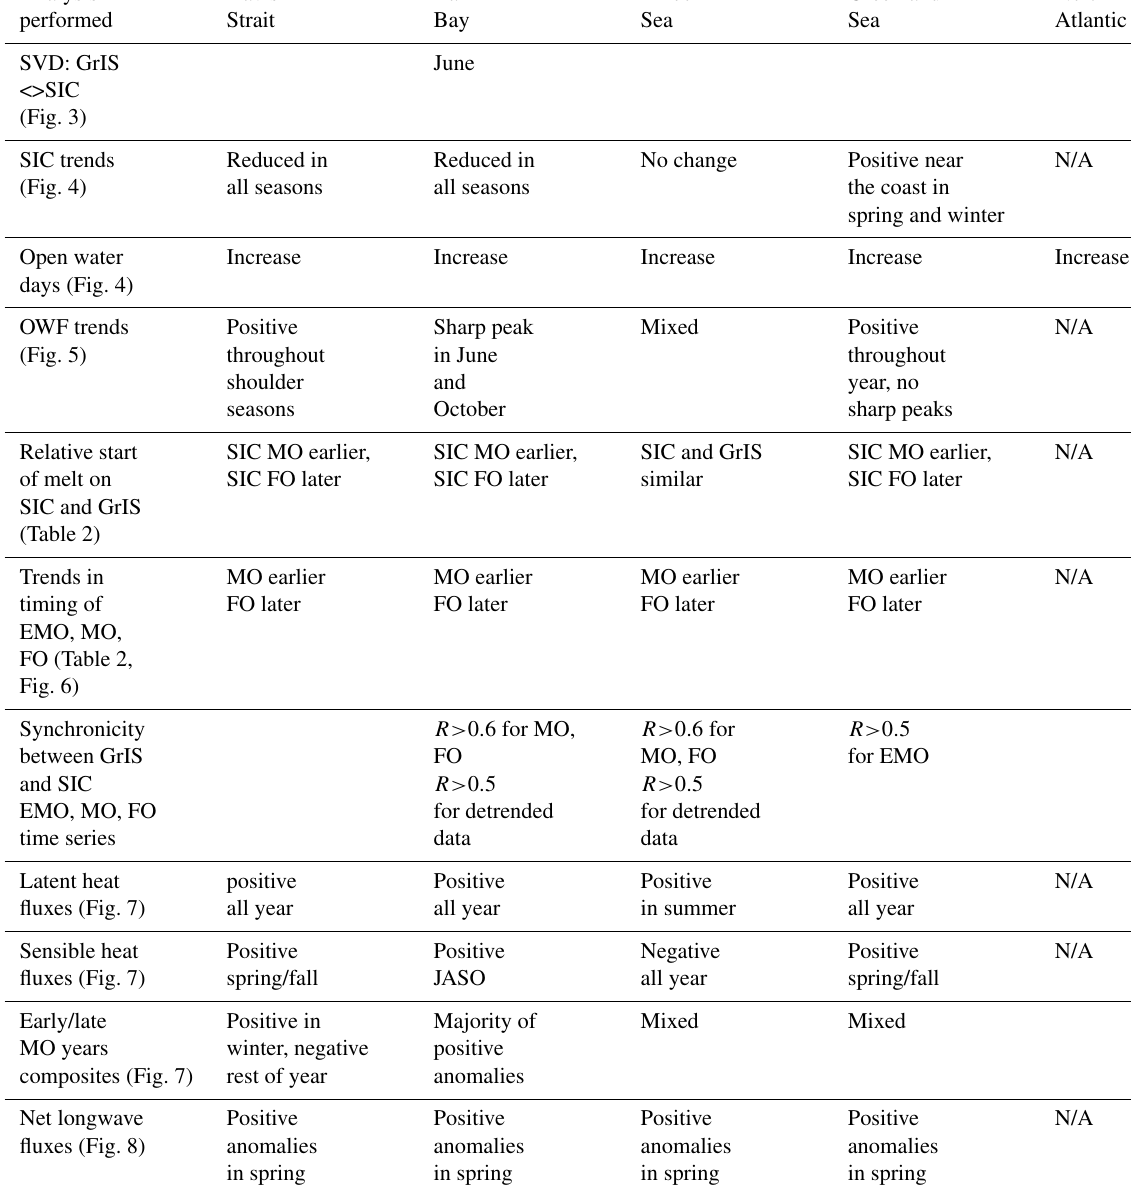
Table 4. Summary table of results discussed in the main body of the paper.